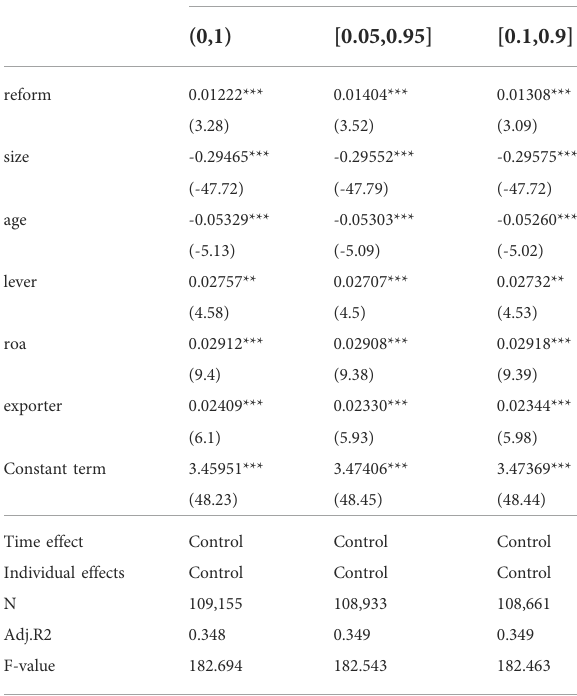
TABLE 6 Measuring mixed ownership reform using the share of non- state